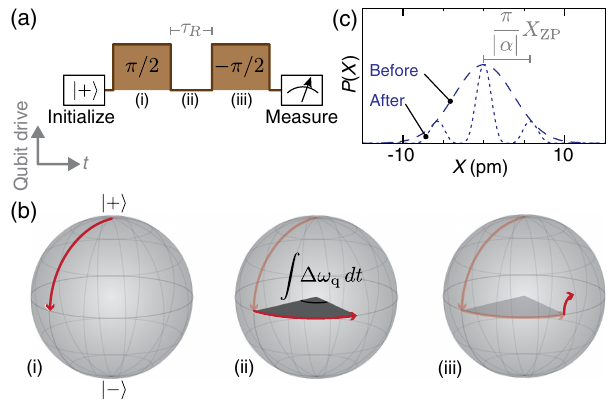
FIG. 3. Using pulsed qubit operations to construct an effective diffraction grating. (a) Pulse sequence. (b) Evolution of the qubit on the Bloch sphere, during (i) preparation, (ii) precession at a = 2 . x rate set by the displacement-dependent qubit frequency shift Δ ω , and (iii) projection. (c) Effect of this pulse sequence on the q ground-state mechanical probability distribution. Conditioning on the qubit measurement outcome jþi , the resonator wave function is multiplied by a periodic filter [Eq. (9)], analogous to a grating. Here, we have taken j α j ¼ 1 . 9